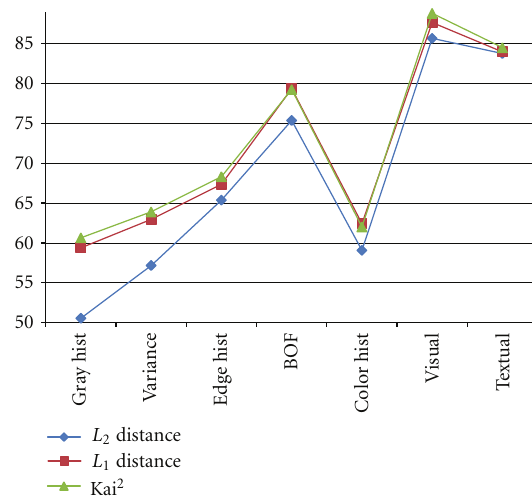
Figure 6: The compared recognition rates with di ff erent features using three types of similarity measures: Euclidean distance ( L 2 distance), L 1 distance, and χ 2 distance. Gray hist, variance, edge hist and color hist represent the histogram of gray, variance, edge, and color, respectively; BOF and textual mean the BOF and textual features.